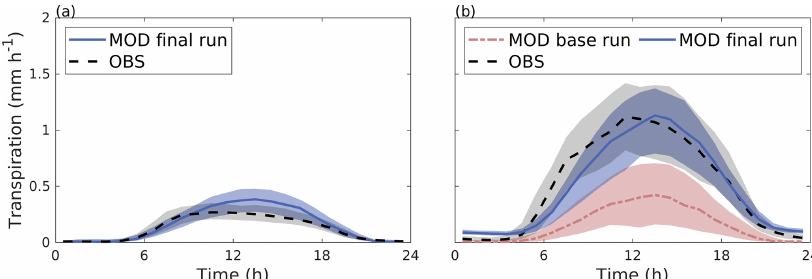
Figure 4. Median diurnal cycle of modelled transpiration (solid blue line) and transpiration estimated from observed sap flow (dashed black line) from June to August 2008–2011 for (a) the Tilia site and (b) the Alnus site. In panel (b) , the red line represents the model simulation without an additional water source (the base run). The shaded areas are the 25th/75th percentiles.